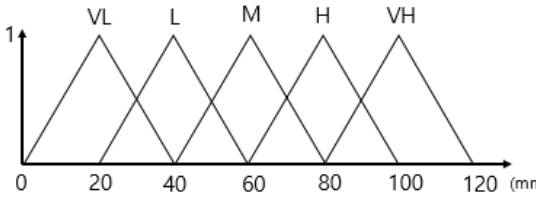
Figure 7. Output membership function of the fuzzy set: cylinder rod stroke.